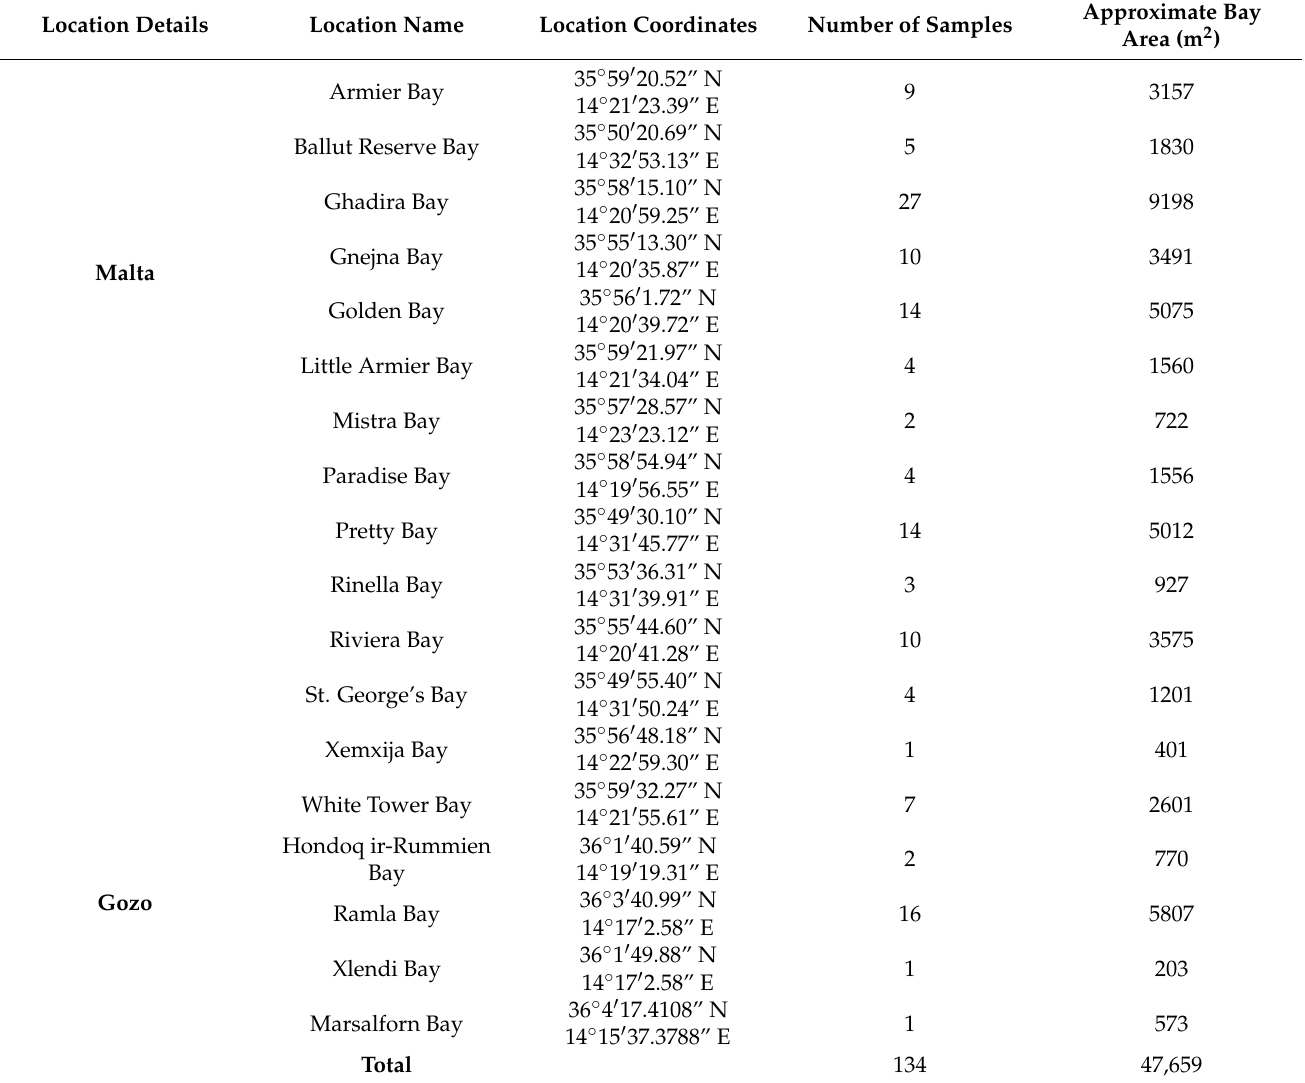
Table 1. List of sand beaches studied and their corresponding number of collected